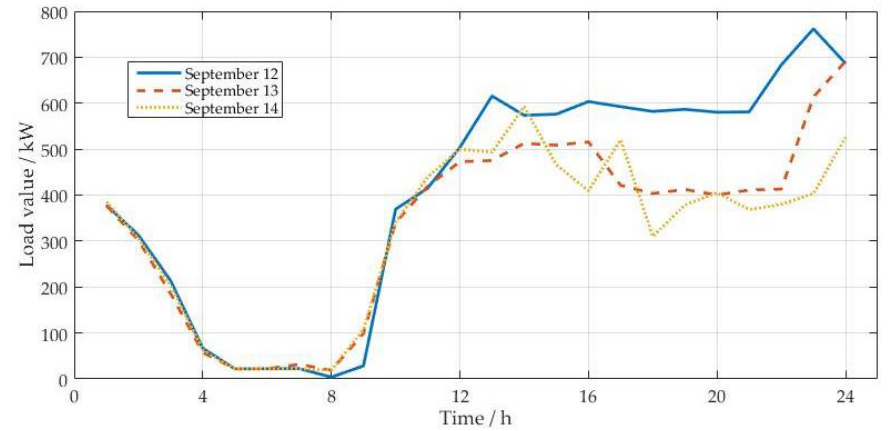
Figure 3. Relationship between temperature and daily load.